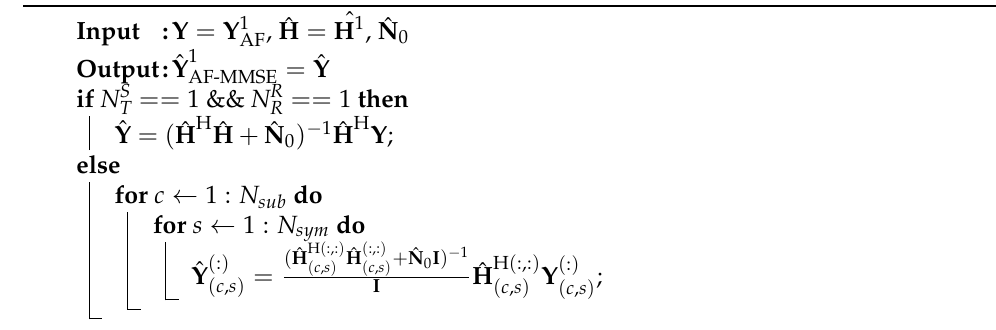
Algorithm 2: Implementation for MMSE Pre-Equalizer